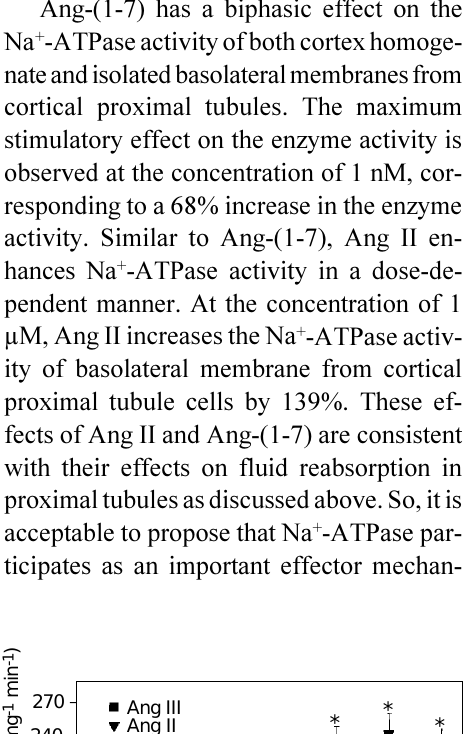
Figure 1. Dependence of Na + - ATPase activity in the isolated basolateral membrane of renal proximal tubules on Ang-(1-7), Ang II and Ang III. ATPase activ- ity was measured as described by Caruso-Neves et al. (9). Each experiment was performed in an independent preparation of basolateral membrane or cortex homogenate . The data were an- alyzed by two-way analysis of variance (ANOVA), considering the treatments as factors. The significance of the differences was determined by the Bonfer- roni t -test. Statistical analysis was performed using absolute values and the results are ex- pressed as percentage of the control. *P<0.05 compared to control (N = 7). N